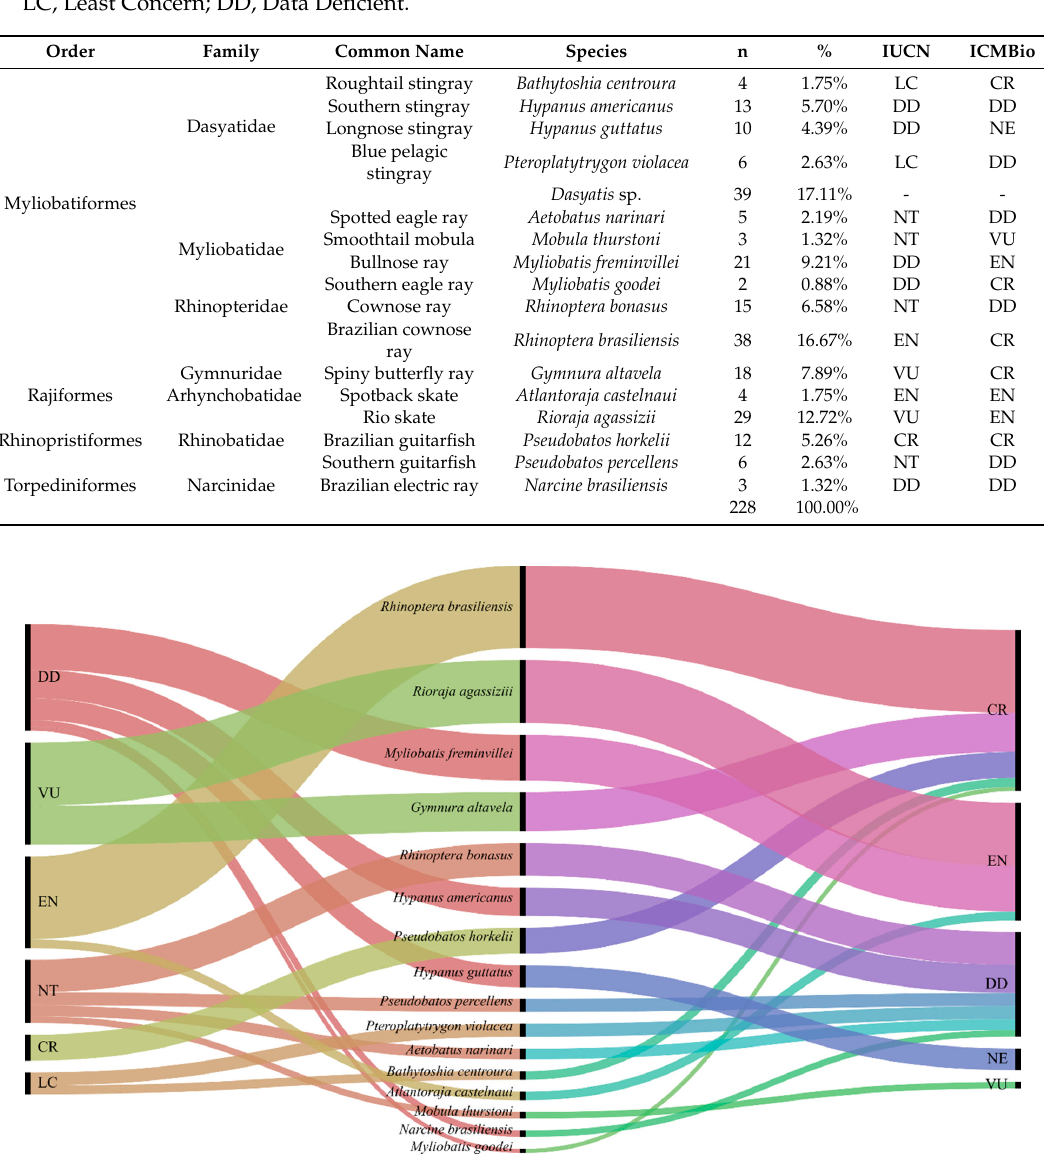
Table 1. Identified batoid species; n, number of identified individuals; %, percentage of total sampling; IUCN, International Union for Conservation of Nature Red List species status; ICMBio, Brazilian Red List species status. CR, Critically Endangered; EN, Endangered; VU, Vulnerable; NT, Near Threatened; LC, Least Concern; DD, Data Deficient.